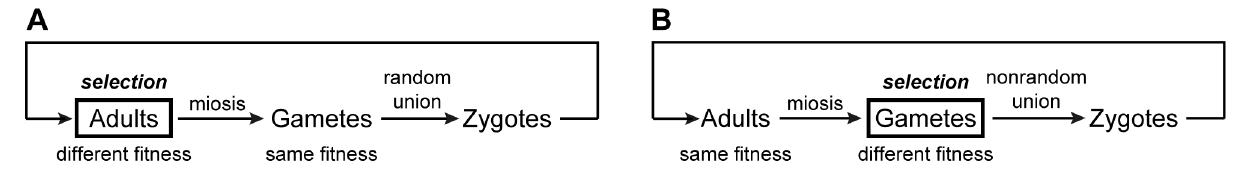
Figure 1. Model of positive natural selection in germline is different from that in individuals. (A) Individuals with different fitness are under selection but gametes have same fitness. (B) Individuals have same fitness but gametes with different fitness are under selection.